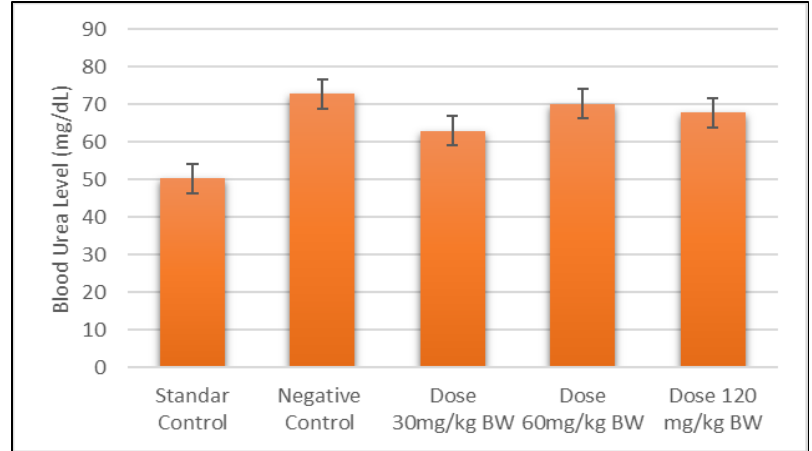
Figure 2: Blood Urea